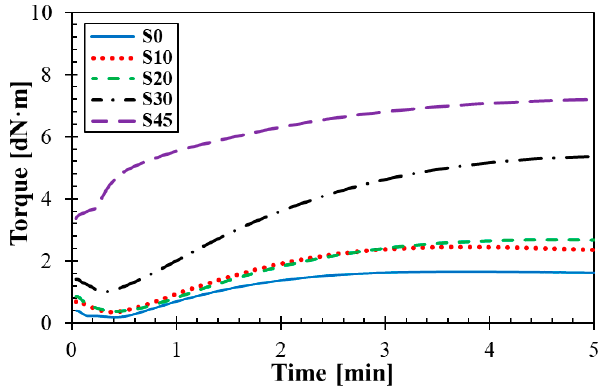
Figure 1. Time dependencies of vulcanization characteristics. Table 2. Curing parameters of the studied rubber composites. Table 2. Curing parameters of the studied rubber